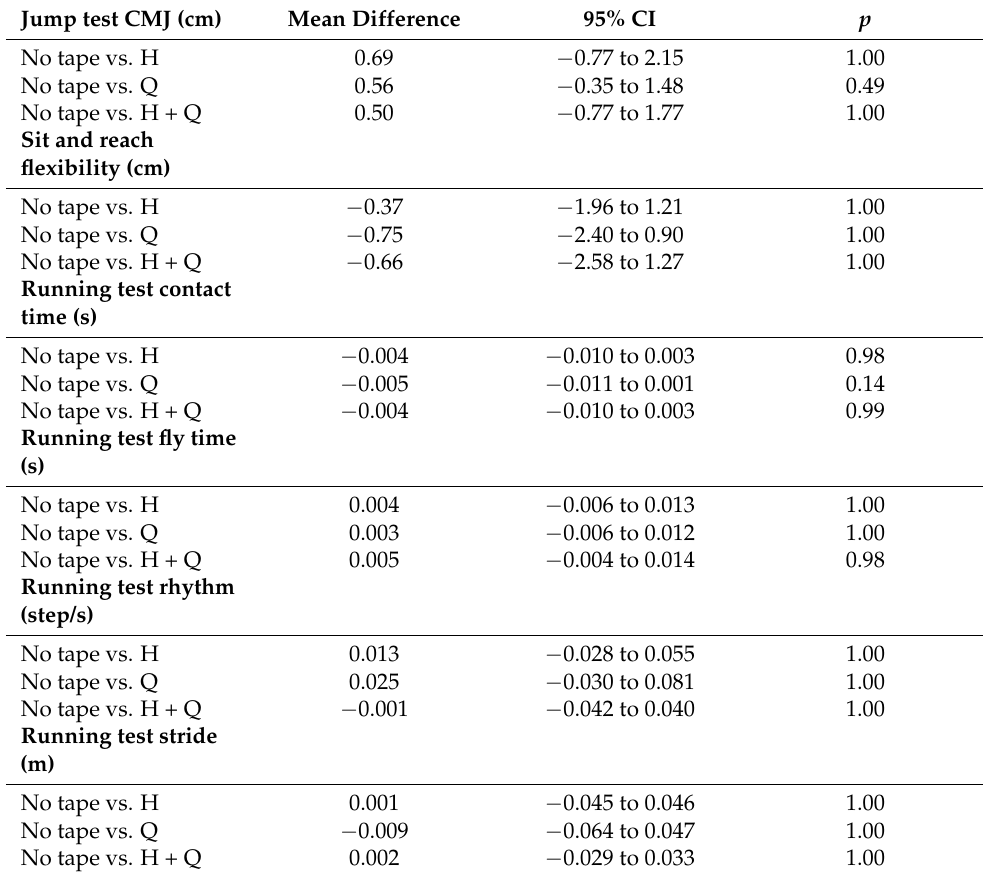
Table 2. Comparisons between no tape and different Kinesio tape ® applications with respect to average jump test, sit and reach test, and running test data. Data are presented as mean difference and 95% confidence interval of the difference ( p = statistical difference between